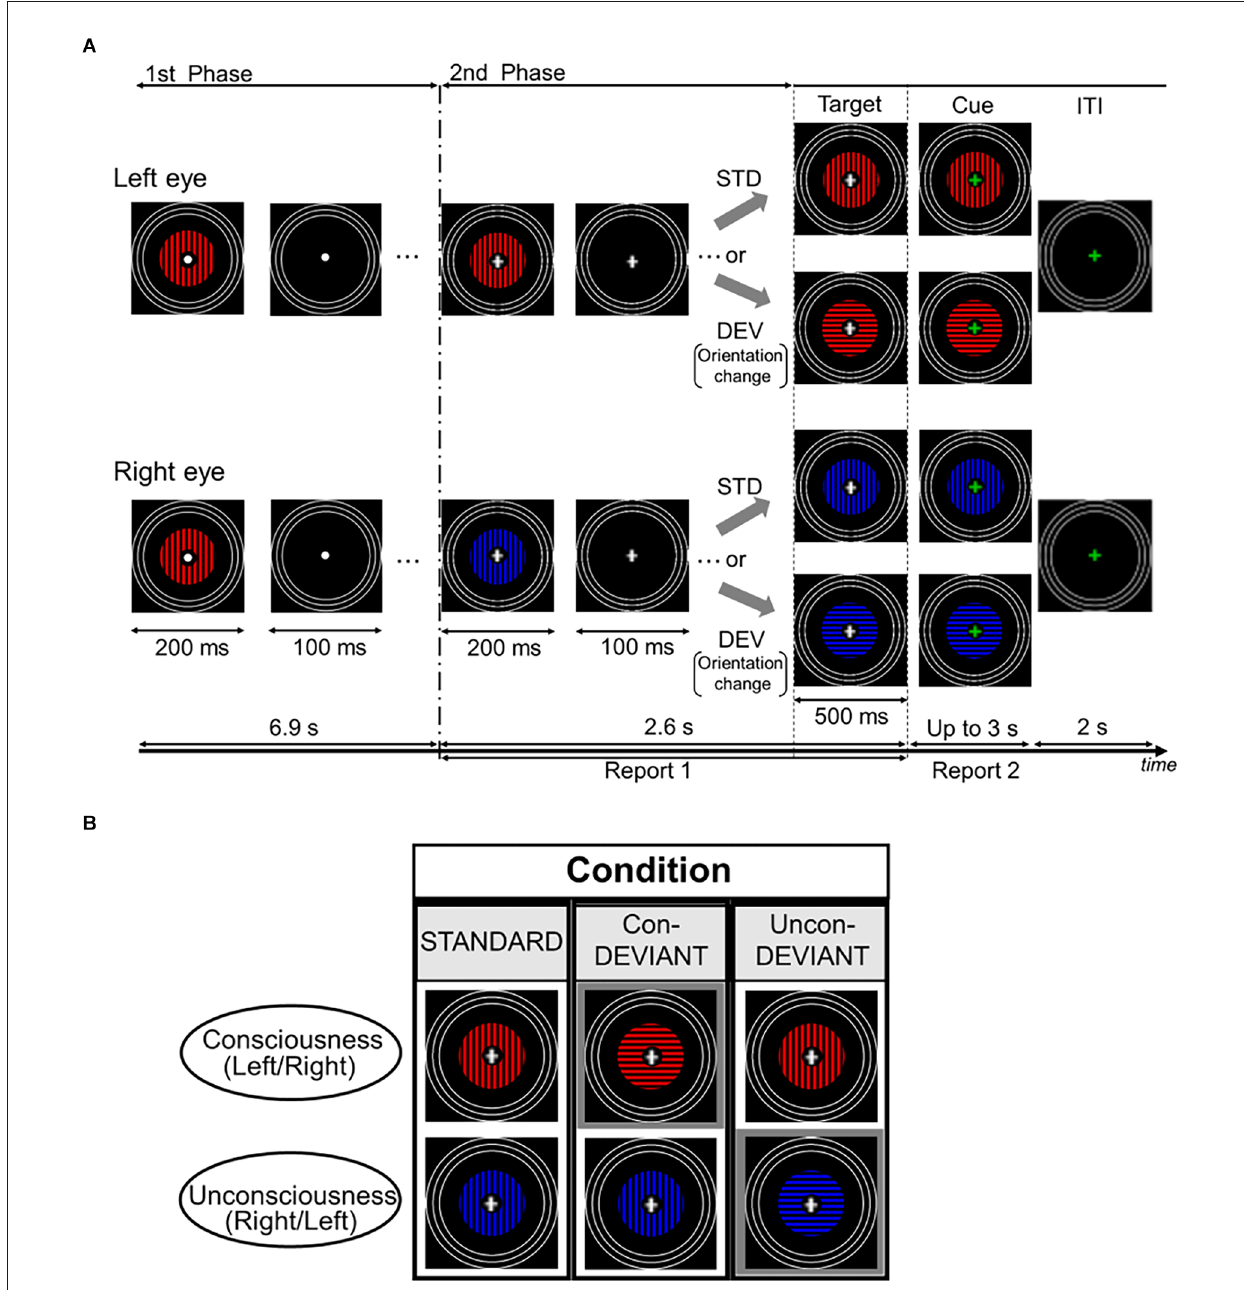
FIGURE1 Time course of stimulus presentation in one trial and experimental conditions. (A) Each trial consisted of two stimulation phases. In the first phase, an identical grating stimulus with a color (blue or red) was simultaneously and intermittently presented for both the left eye and the right